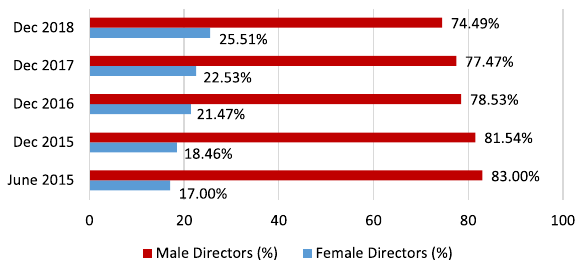
Fig. 1 Percentage of Unique Directors by Gender (2015 and 2018)